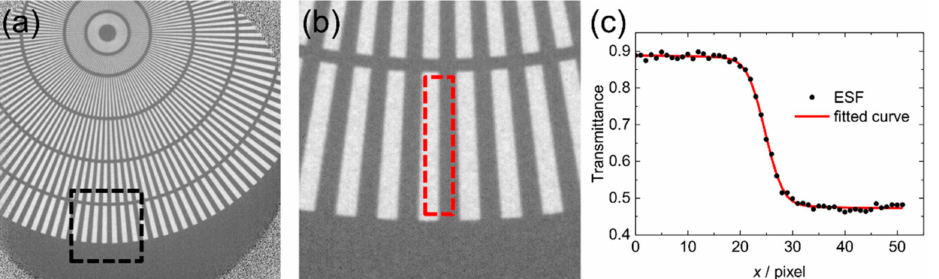
Figure 2. Process of obtaining ESF from a neutron transmission image: ( a ) whole image example, ( b ) enlargement of the dashed area in ( a , c ) ESF of the dashed area in ( b ) and fitting